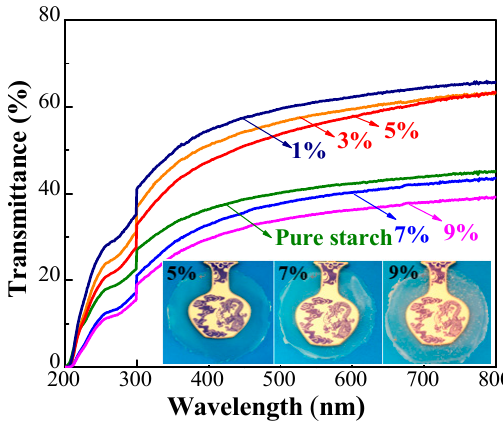
Figure 4. The UV-Vis spectrum of pure starch films and composite films with various dosages of ZnO NPs.